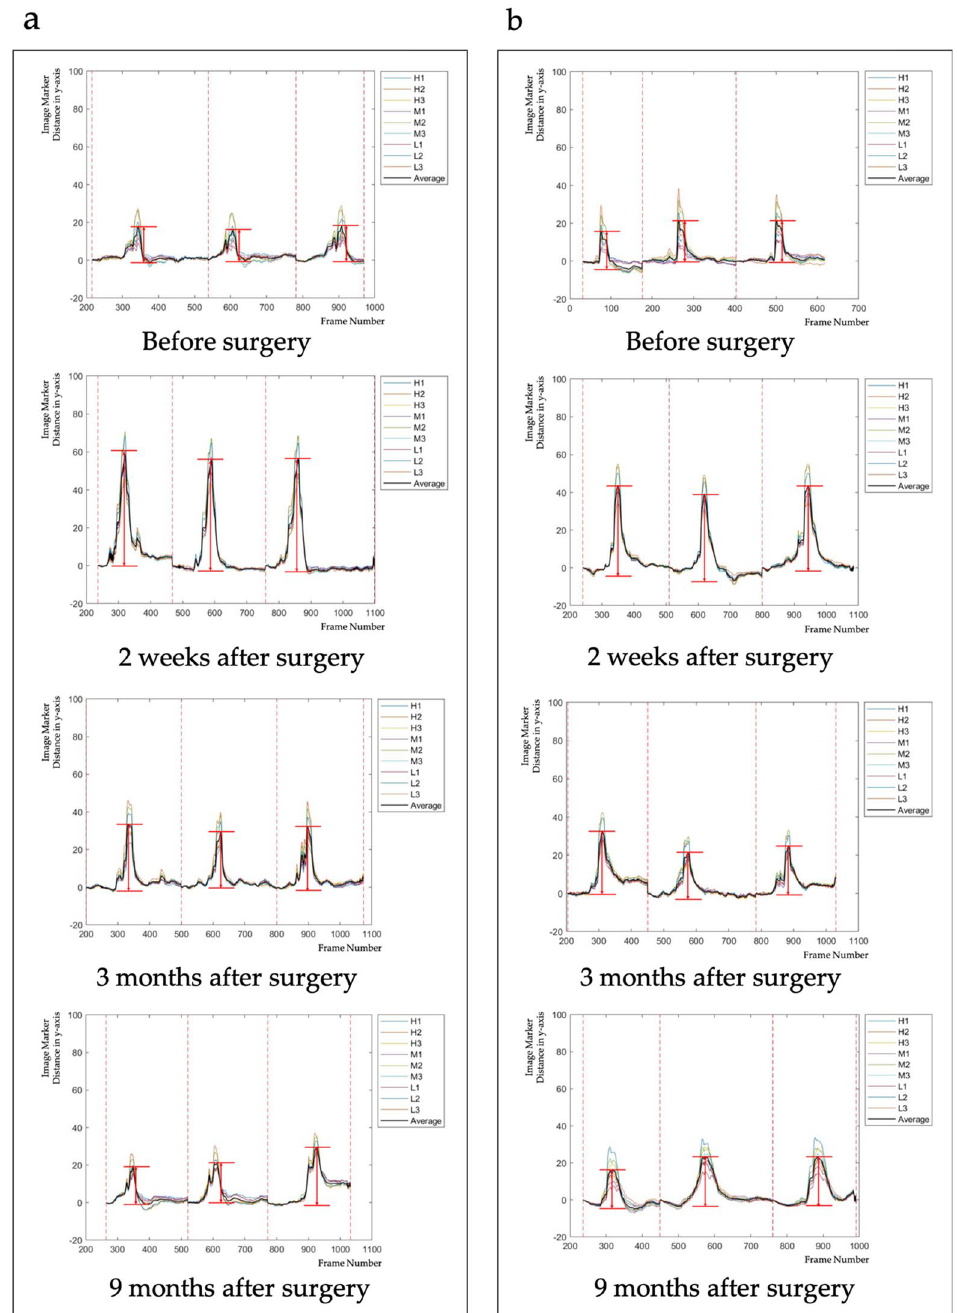
Figure 1. Image marker distances moved before surgery, and 2 weeks, 3 months, and 9 months after surgery in patients who underwent thyroidectomy ( a ) with and ( b ) without an anti-adhesion